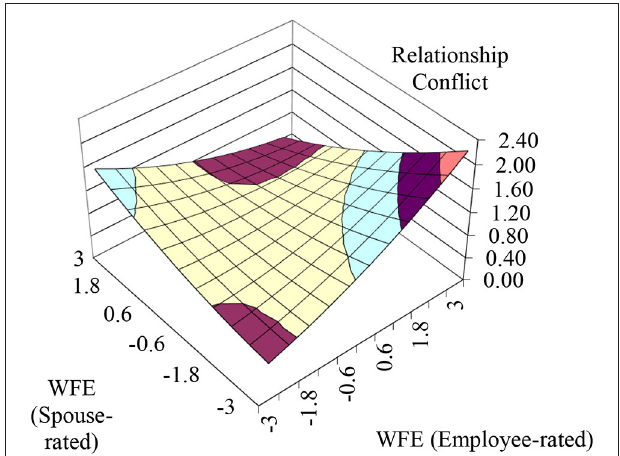
FIGURE 2 | The congruence effects of employee-rated and spouse-rated employee WFE on relationship conflict.